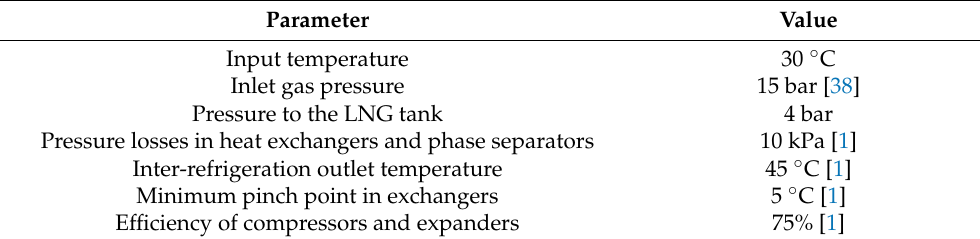
Table 1. Process